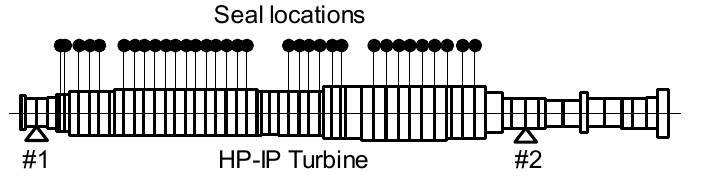
Fig. 18. Finite Element Model of the HP-IP turbine and location of the main groups of